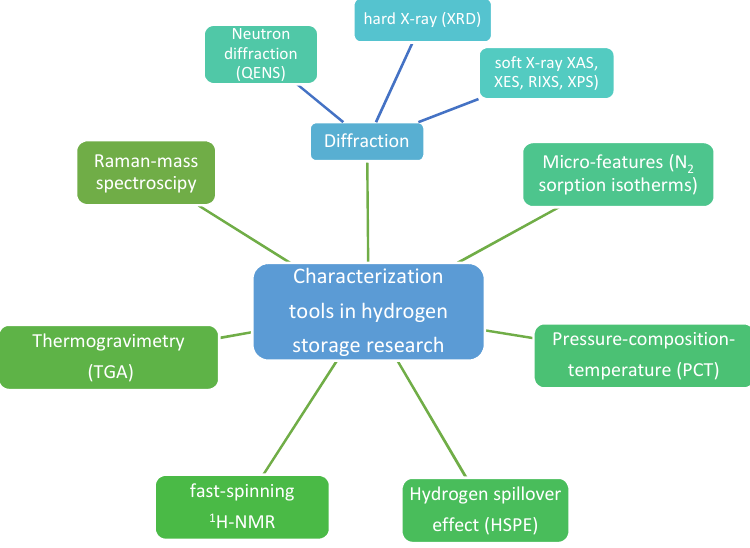
Figure 1. Main investigation methods used for characterization of hydrogen storage materials.